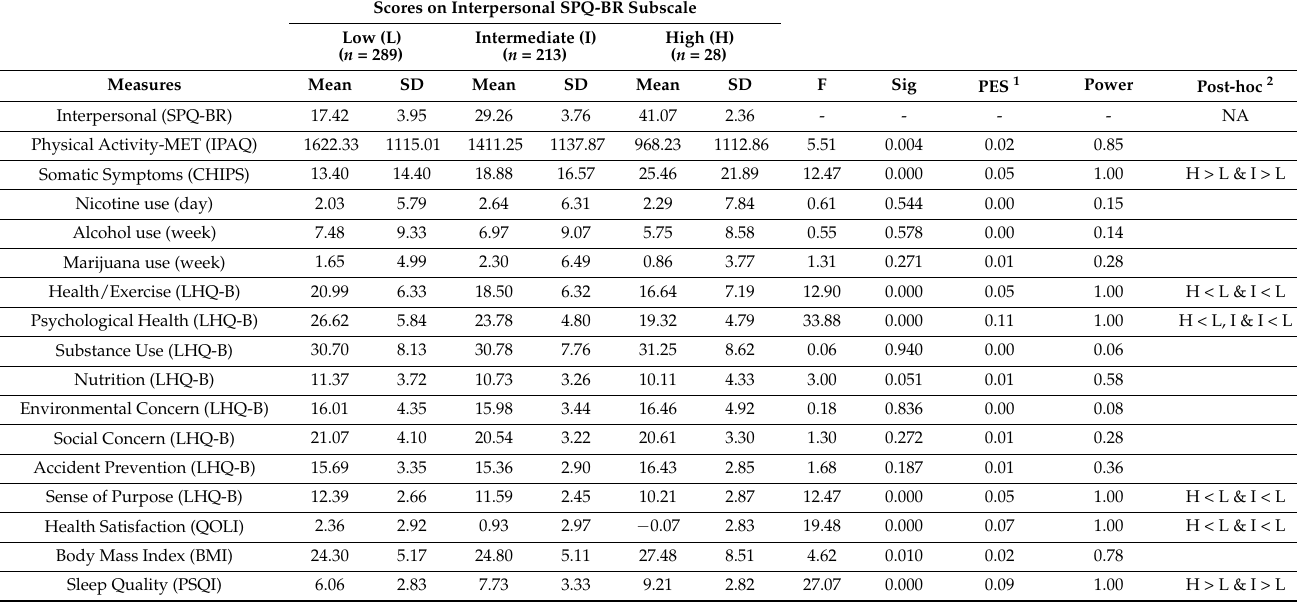
Table 3. Descriptive information for study variables and MANOVA results organized by high, intermediate, and low Interpersonal (negative) schizotypy groups.